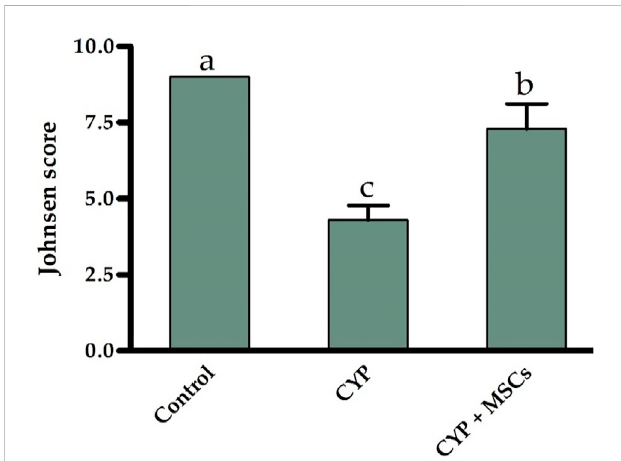
FIGURE 5 In fl uences of CYP with/without MSCs transplantation on Johnsen score for the seminiferous tubules. Data described as mean ± SD (n = 6). DMRTs show that bars with various letters are substantially different at p =